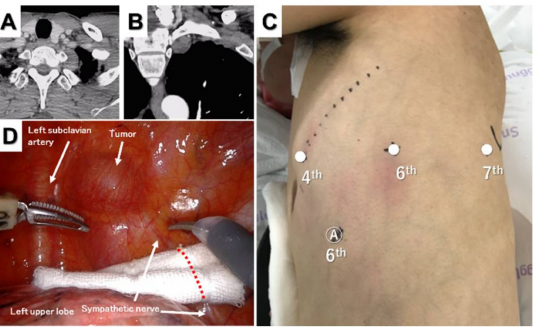
Figure 5. Superior sulcus tumor. Horizontal ( A ) and sagittal ( B ) computed tomography views of the tumor. Port placement for three-arm robotic resection of a superior sulcus tumor ( C ) and intraoperative thoracoscopic view of the tumor ( D